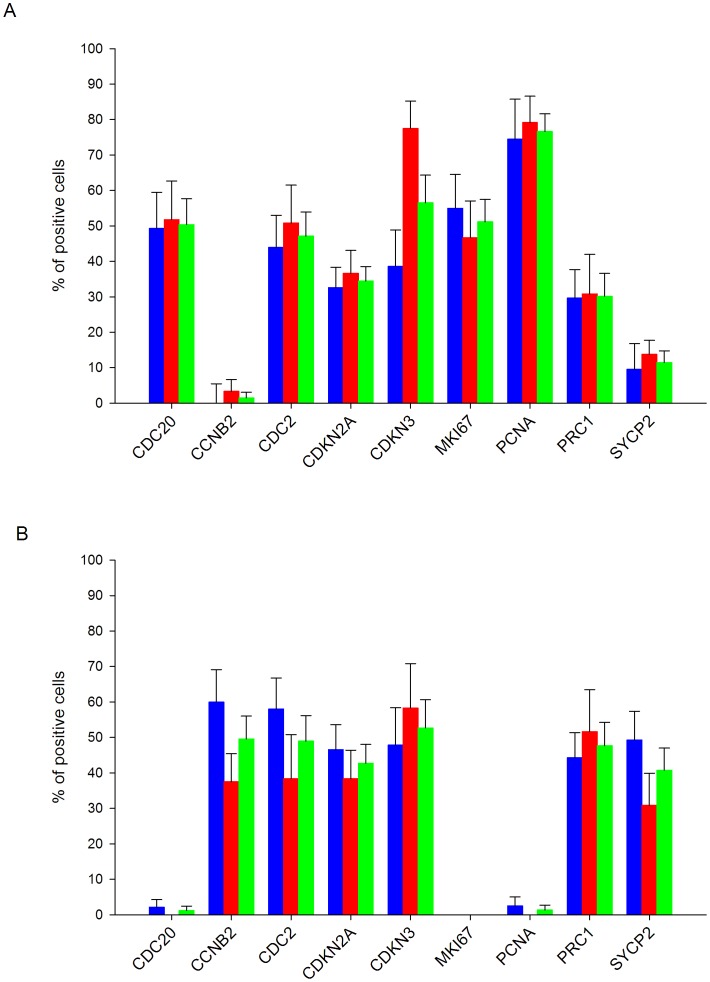
Percentage of tumor cells with positive signals for the markers tested by immunohistochemistry.The average percentages of tumor cells with positive signals in the nucleus (panel A) or cytoplasm (panel B) for CDC20, CCNB2, CDC2, CDKN2A, CDKN3, MKI67, PCNA, PRC1, and SYCP2 are plotted. Tumors positive for HPV16 (blue bars) are compared with tumors positive for other HPVs (red bars). As NUSAP1 was only explored in HPV16-positive CCs, the average percentages of tumor cells with positive signals in nuclei (32.5%) and cytoplasm (68.4%) were not included in this figure. The numbers for the entire set of tumors is also included (green bars). The standard error is shown.